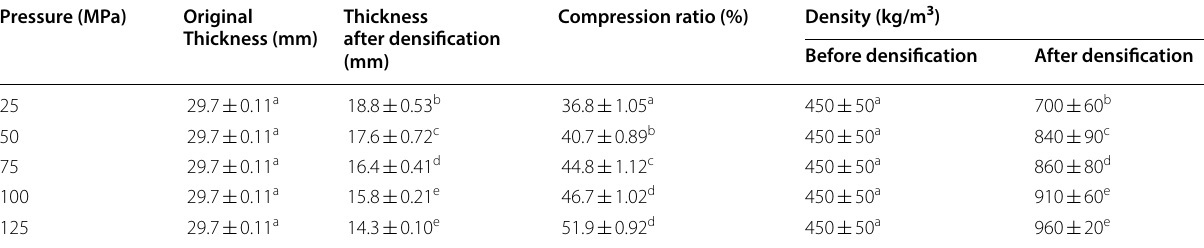
Measured values are represented as mean standard error of 15 replicates. Means followed by the different letters (a, b, c, d and e) are significantly different among ± original thickness and thickness after densification ( p < 0.05). Means followed by the different letters (a, b, c and d) are significantly different among CR ( p < 0.05). Means followed by the different letters (a, b, c, d and e) are significantly different among density ( p < 0.05)